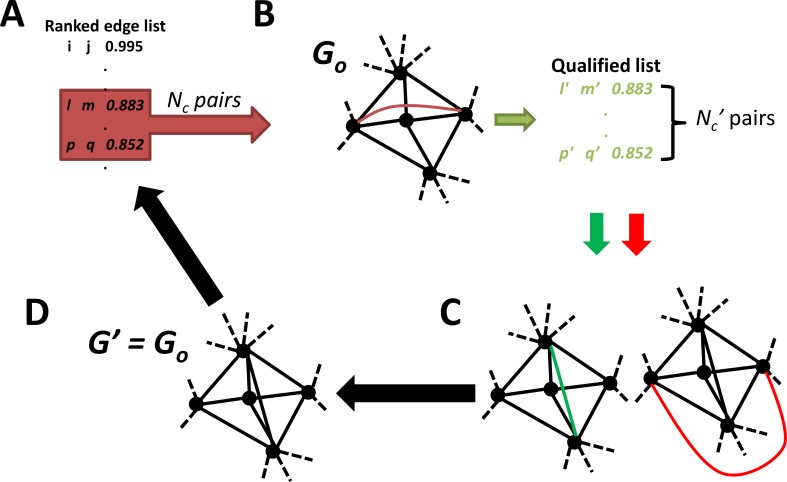
Fast PFN construction.A parallelized screening procedure is developed to extract a subset of gene pairs which are highly likely to be embedded. A) FPFNC begins with a rank-ordered list of association pairs. B) Then a subset of N
c pairs undergo parallelized quality control by their embeddability on a single platform of G
o to identify the pairs which are more likely embedded in the subsequent network construction steps. C) These screened set of N
’
c pairs are then tested on the growing embedded network subsequently. D) A final updated network G
’, which will be used as G
o on the next cycle. The whole processes are repeated until the defined criterion for termination is met.